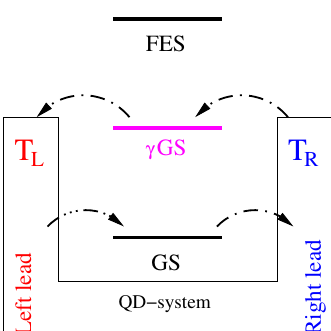
Figure 5. Diagram showing the photon-activated resonance energy levels and electron transition by the photon-induced processes via γ GS.